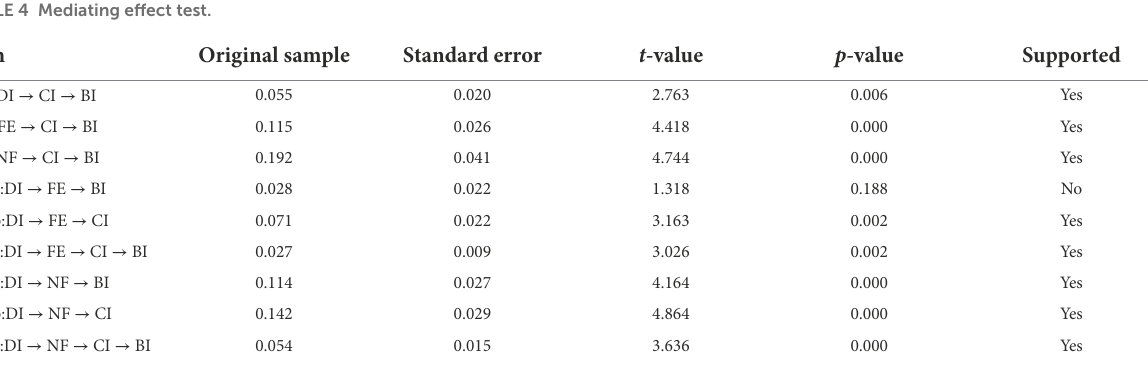
TABLE 4 Mediating effect